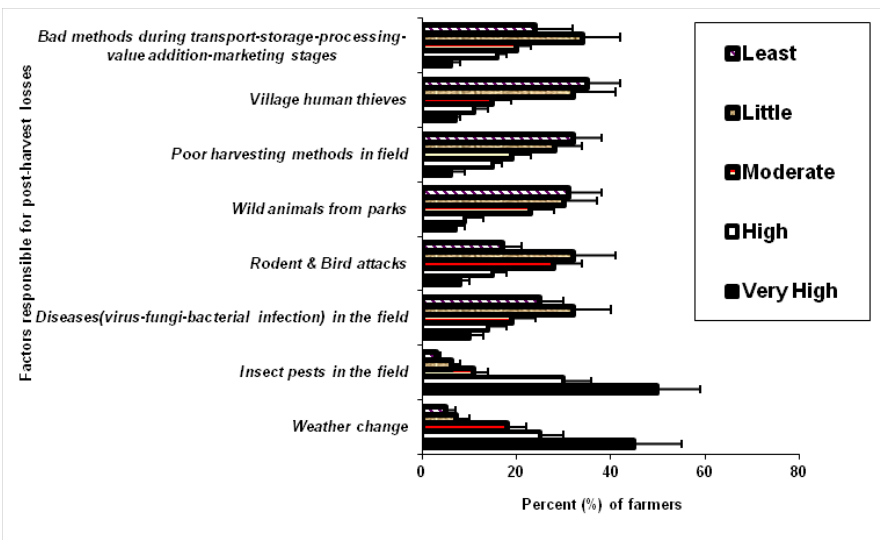
Figure 1b. Farmers’ perceptions about factors responsible for post-harvest losses in sweet